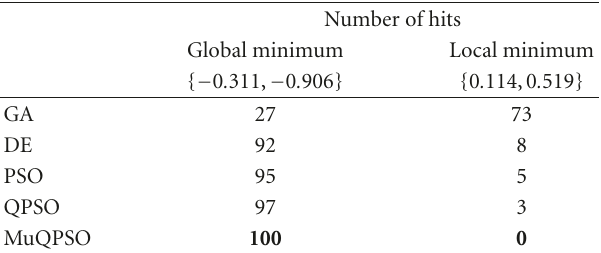
Table 2: Example 1 with randomly chosen initial positions for system